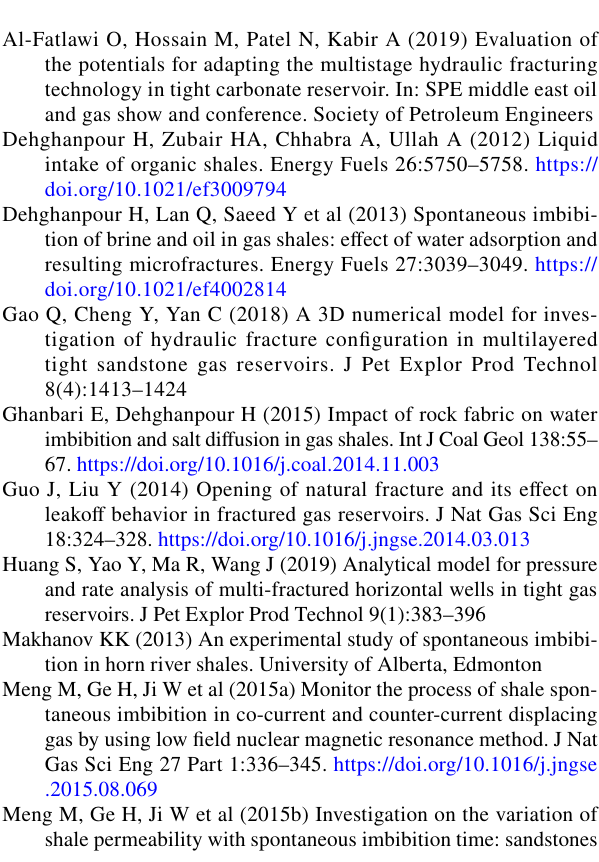
Table 8 Variation of core sample physical properties before and after imbibition (KClC is the KCl concentration; PobI is the porosity before imbibition; PoaI is the porosity after imbibition; PorA is the Exp.